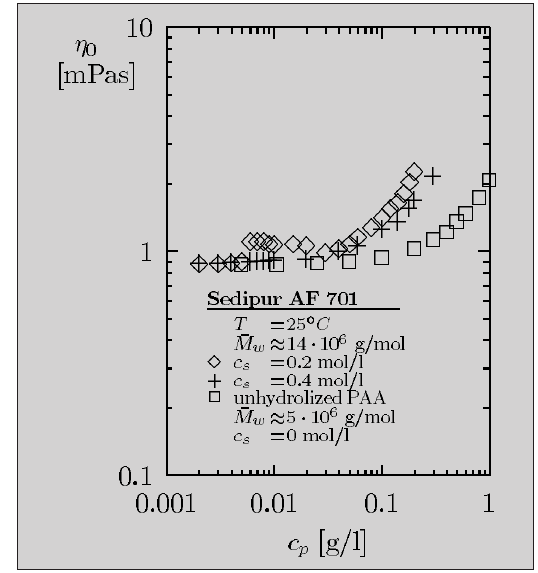
Figure 3 (left): The shear viscosity as a function of the shear rate for the different polymer